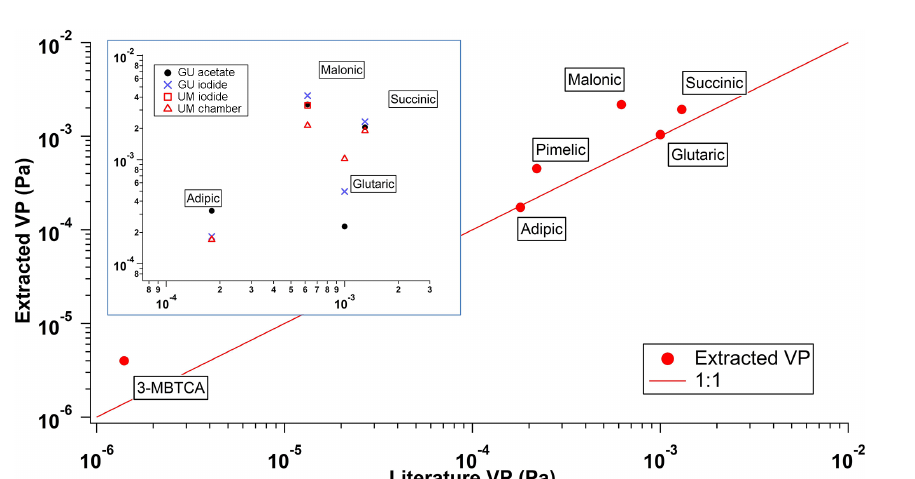
Figure 6. Extracted VP from the UMan FIGAERO plotted against reported VPs from the literature. These measurements are made using the UMan instrument from the Manchester SOA chamber experiments (see Table 3). Direct comparisons are made for adipic, glutaric, malonic and succinic acids, which were measured in both the single-component and chamber study, shown on the inset panel. Axes are as described in the main figure. Total mass concentrations in the chamber ranged from 0 to 60µgm − 3 throughout the complete